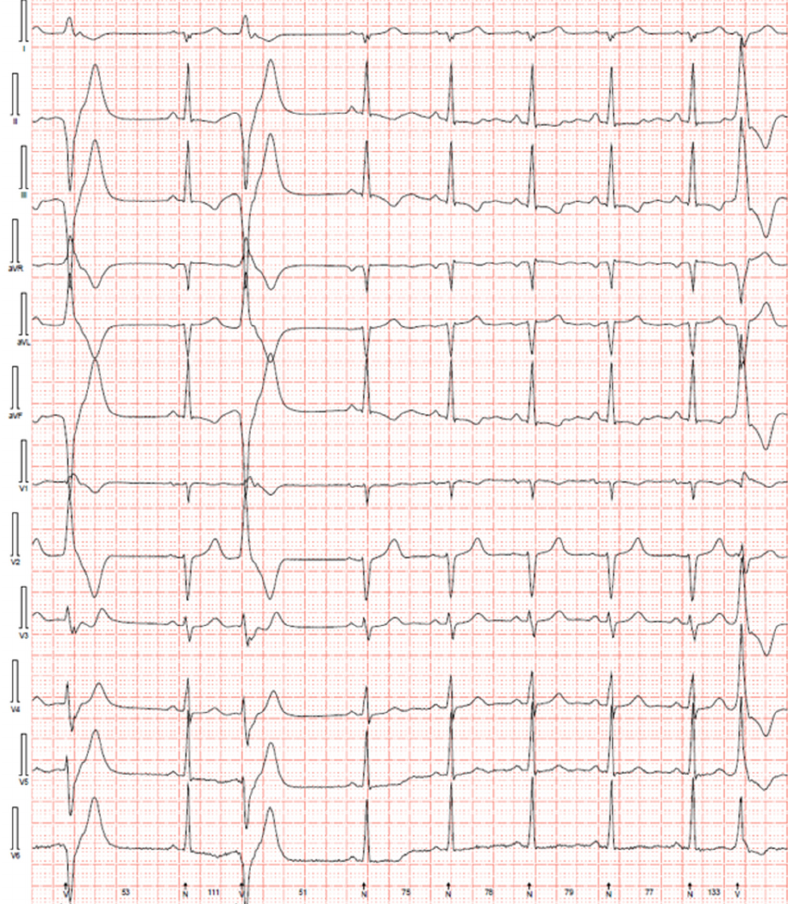
Figure 2. Electrocardiographic findings of arrhythmic mitral valve prolapse. Readings from 12-lead Holter monitoring demonstrating multifocal PVCs as well as T-wave inversions in leads II, III, aVF in a young otherwise healthy woman with bileaflet mitral valve prolapse, mitral annular disjunction, and a high burden of symptomatic premature ventricular contractions. The patient was inducible for sustained polymorphic VT during electrophysiology study and underwent subcutaneous implantable cardiac defibrillator (ICD) implantation. Individual studies produced conflicting results on whether patients with MVP with arrhythmias have longer corrected QT intervals [29,30,39,50], but a meta-analysis suggests the corrected QT interval was longer by 14.7 msec [49]. Although the corrected QT interval may be longer on average, the averages are typically not prolonged. There is not a clear threshold that predicts arrhythmias.